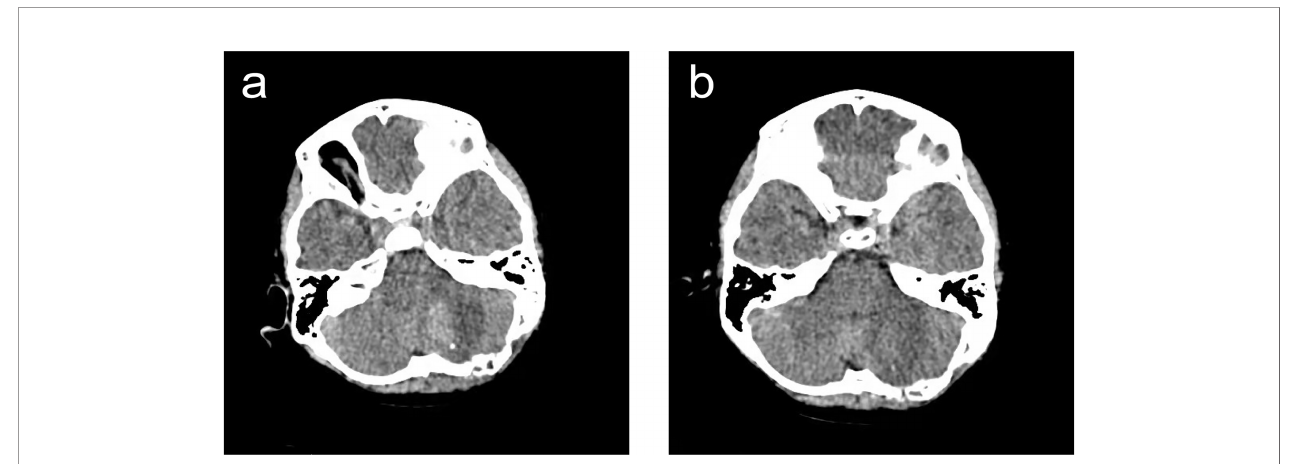
FIGURE 3 | Radiological evaluation of YST post operation. CT scanning of the residual tumor on day 7 (A) . and two weeks after operation (B) . The size of the residual tumor signi fi cantly decreased. Patchy hyperdense shadow was seen in the left cerebellar hemisphere, surrounded by patchy low-density edema. No obvious abnormalities were found in the ventricle or cisterns. Displacement of middle structure was not found.